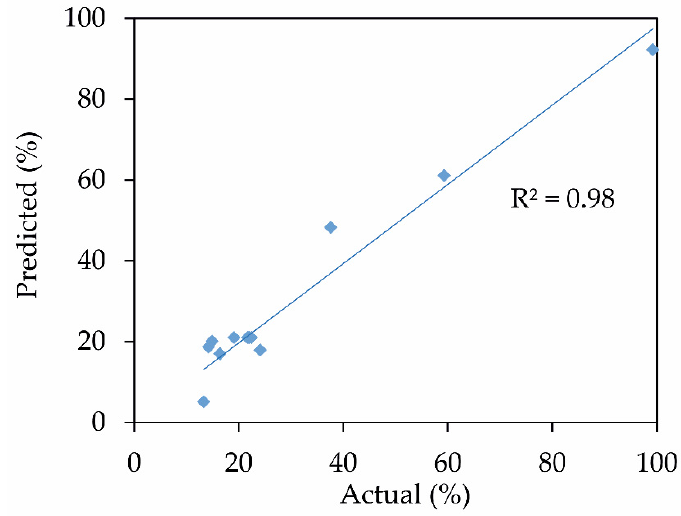
Figure 3. Real and predicted values of the removal efficiency of arsenic (III).